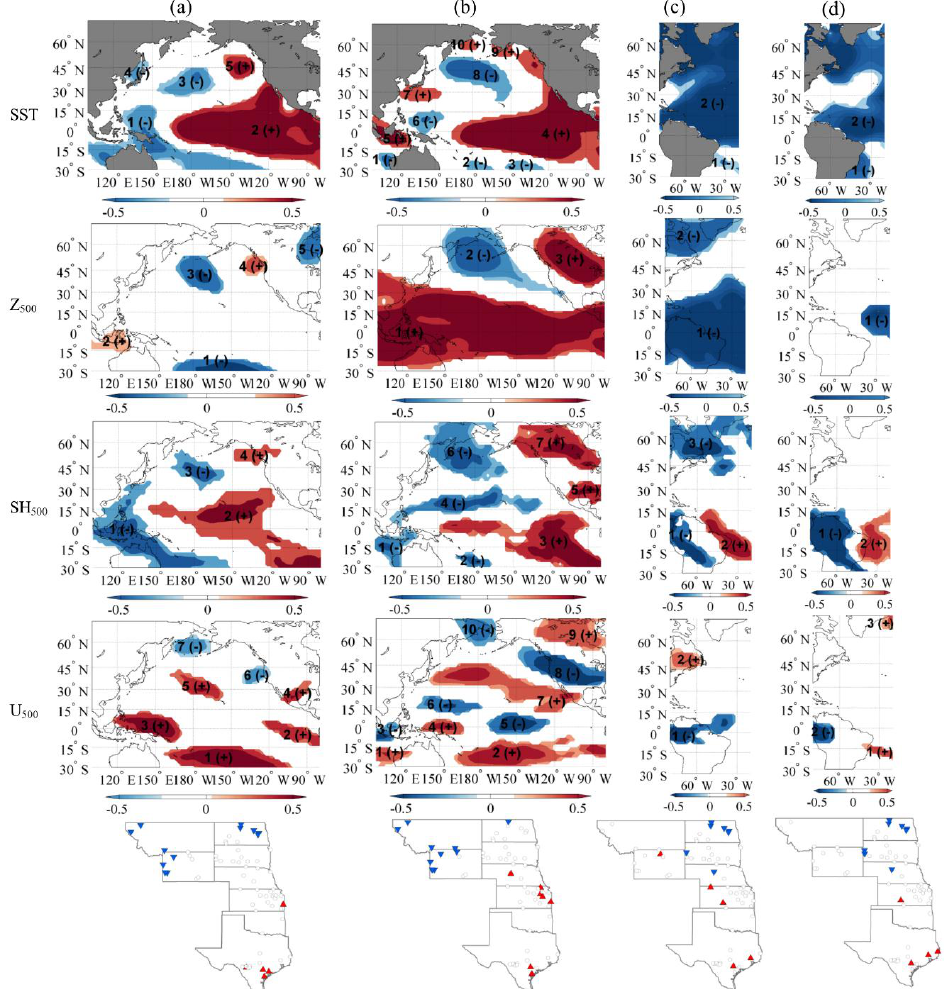
Figure 2. Heterogeneous correlation map developed for ( a ) Pacific September–November, ( b ) Pacific December–February, ( c ) Atlantic September–November, ( d ) Atlantic December–February SST, Z 500 , SH 500 , and U 500 with Great Plains April–August streamflow. Significant regions with positive (negative) correlations are represented by red (blue). Significant streamflow stations are represented by red upward (blue downward)